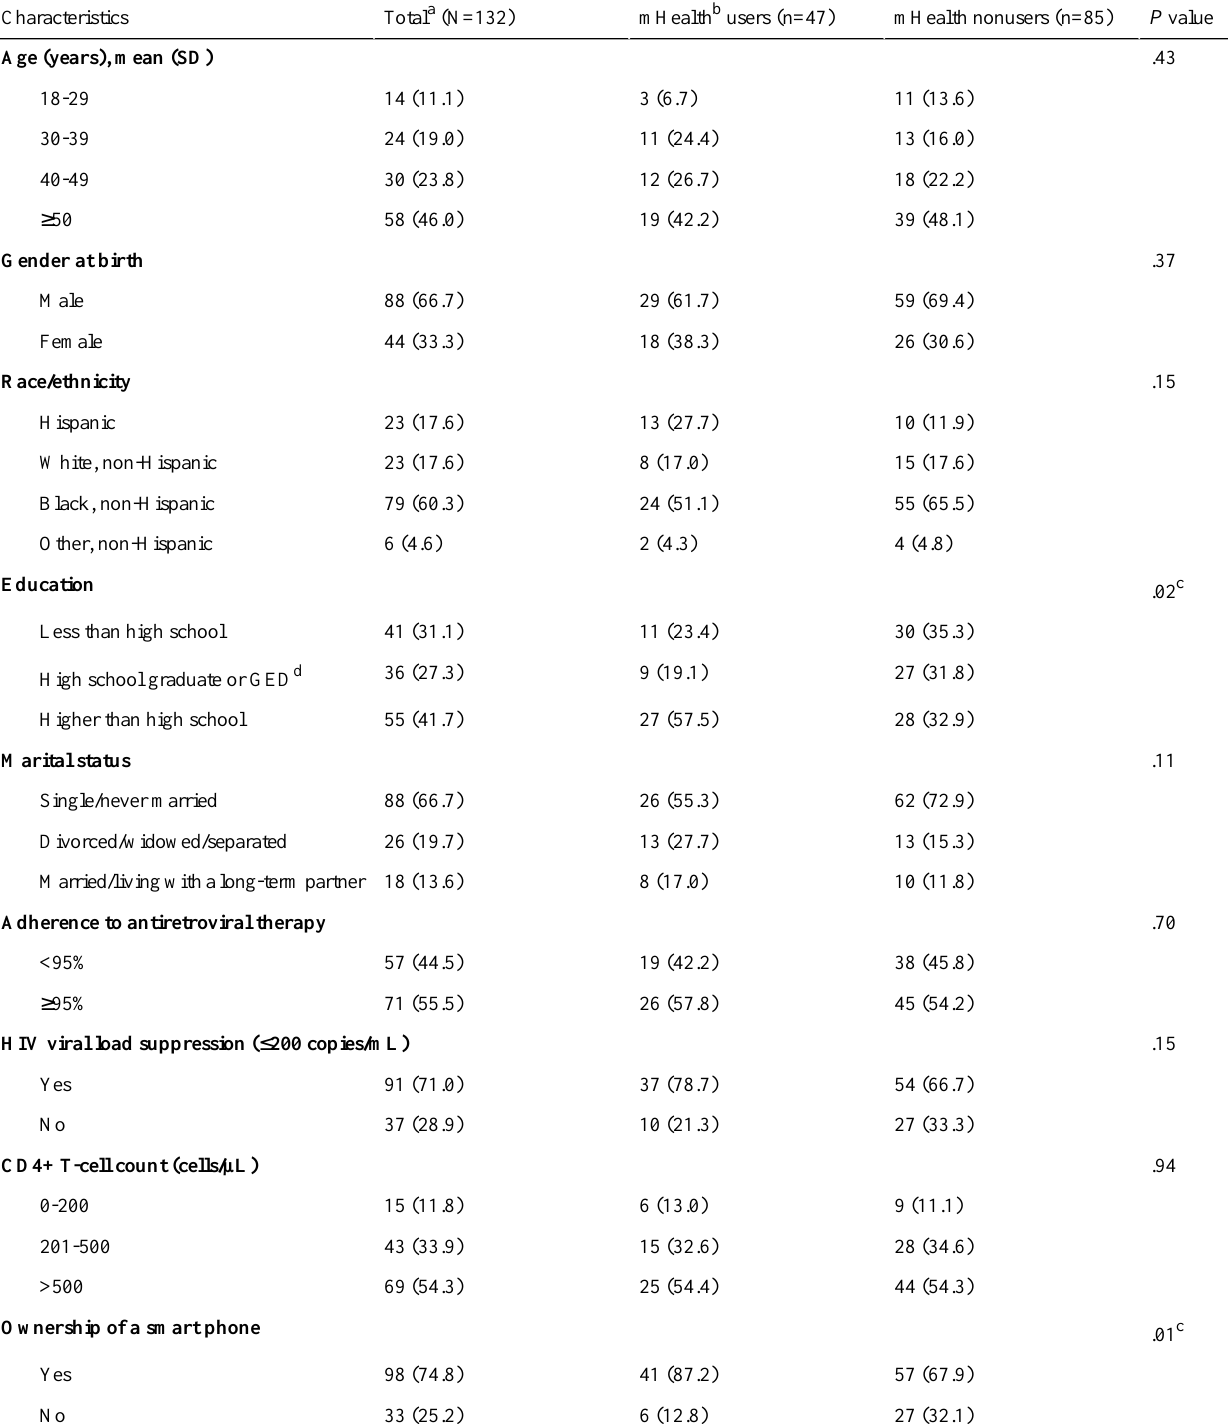
Table 1. Baseline characteristics of mobile health platform users and nonusers among people living with HIV/AIDS (PLWH) in the Florida mHealth Adherence Project for PLWH Study,